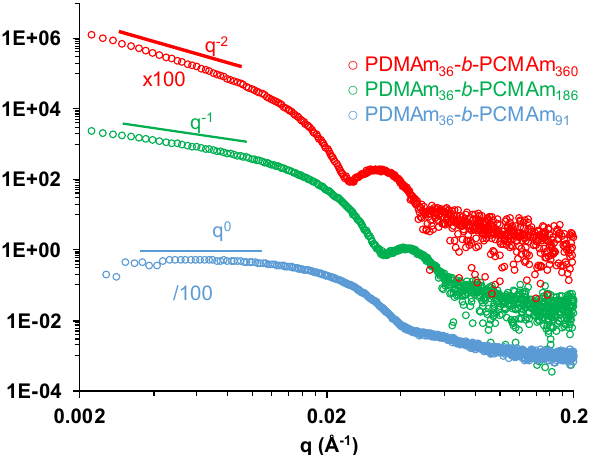
Figure 3. SAXS intensity (I(q)) versus scattering vector (q) for PDMAm 36 - b -PCMAm x ( samples 5, 6 and 7 ) in water at 1 wt% at 25 °C.